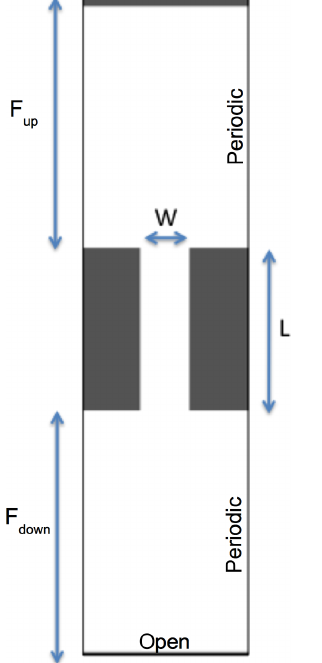
Figure 3. Idealized domain with a solid wall to the north, open boundary to the south, and periodic boundaries to the east and west. The channel in the control simulation has a width W = 60km, length L = 200km, and fetch F up and F down = 300km in the up- stream and downstream basins, respectively.